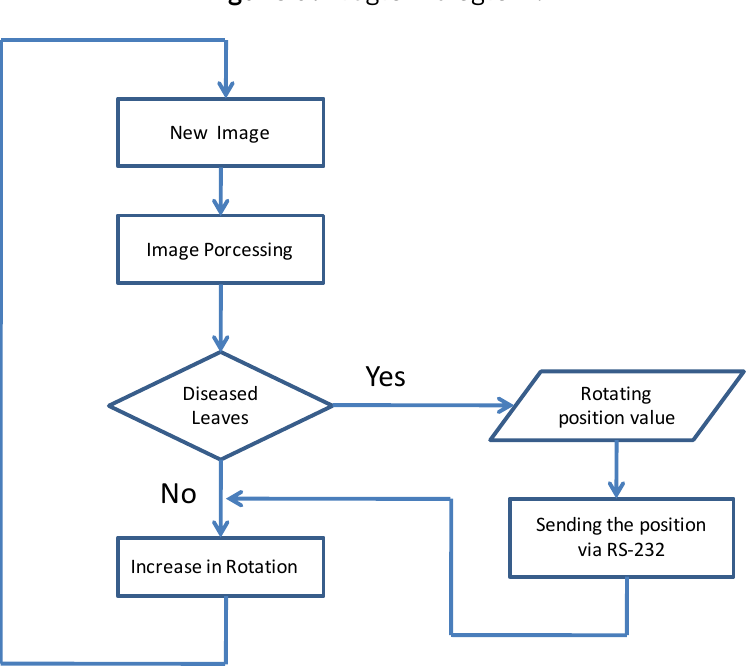
Figure 6. Program